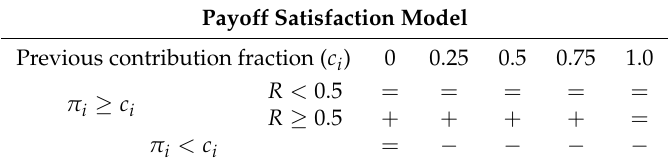
Table 1. In the payoff satisfaction model, the agent decreases its contribution fraction to PGG when the received payoff π i is less than the contributed amount c i . Otherwise, it increases its contribution or keeps the previous one with uniform probability. Here, R represents a uniform randomly generated number in [0,1]. Payoff Satisfaction Model Previous contribution fraction ( c i ) 0 0.25 0.5 0.75